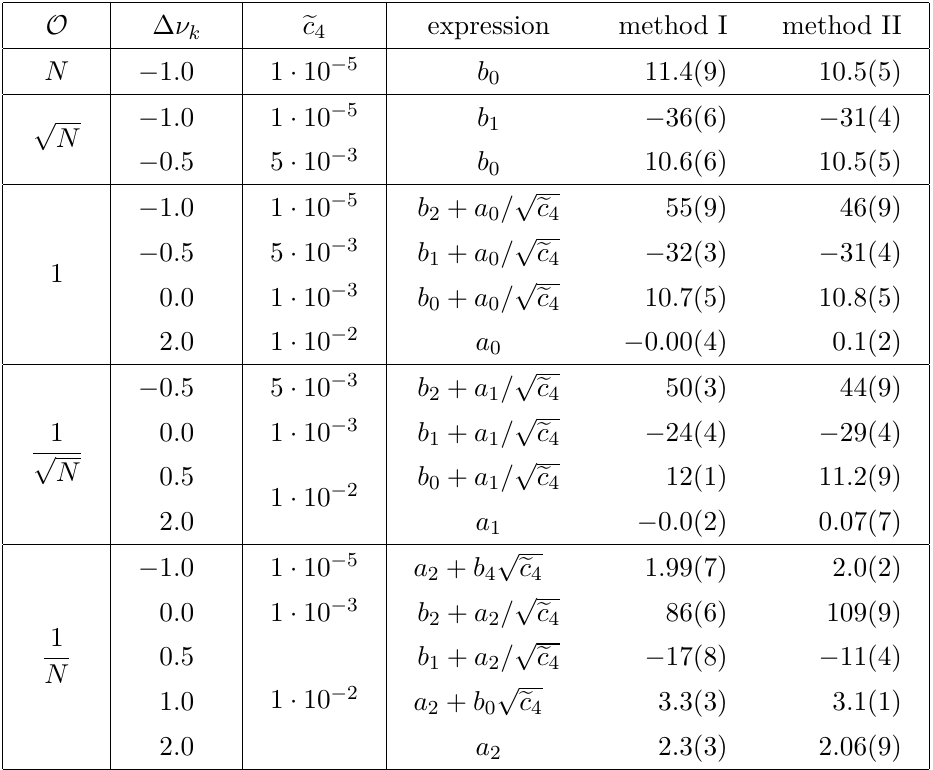
Table 3 . Comparison of the estimates of a i and b i using fits for different ∆ ν k and fixed I, using (5.4)) to the estimates from ν k = 0 and variable deformed Wigner semi-circle. Meanwhile the trace distribution stays centered at